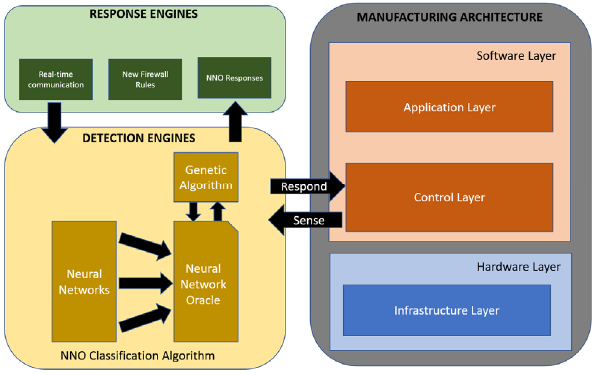
Figure 6. NNO Classification algorithm